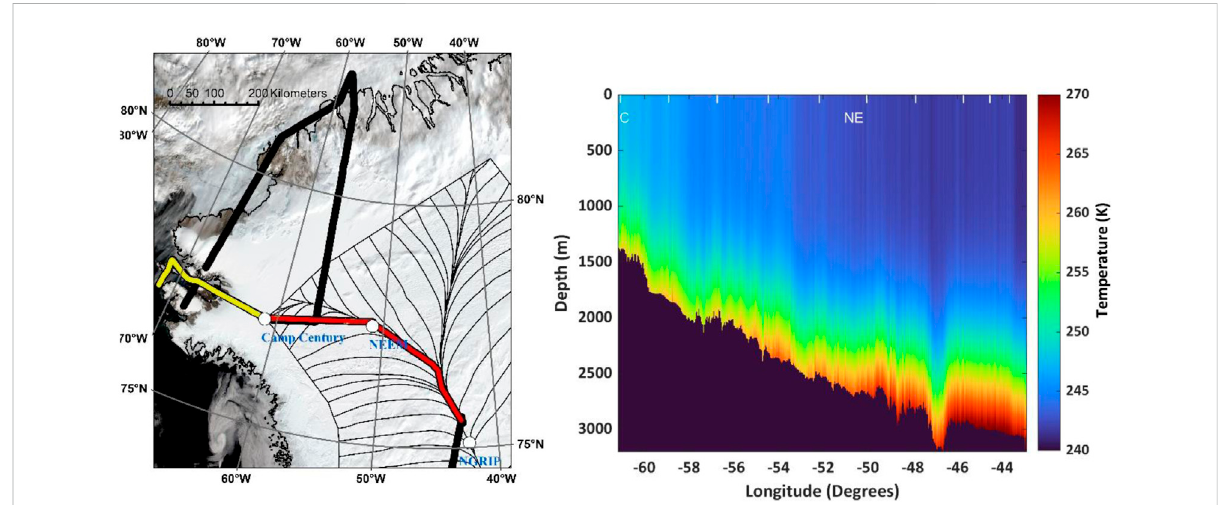
FIGURE 7 UWBRAD transects across Greenland (left). The 2016 Greenland fl ight is shown in yellow. The 2017 Greenland Flight is shown in black. The portionofthe2017linealongwhichintraglacialtemperatures(right)wereestimatedisshowninred.Slope-derivedice- fl owlinesextendingfromthe ice divides are shown by thin black lines. Derived temperature pro fi les along the survey line from Camp Century (C), to NEEM (NE) to NGRIP (near end-of-line) Greenland (right) (From Yardim et al.,